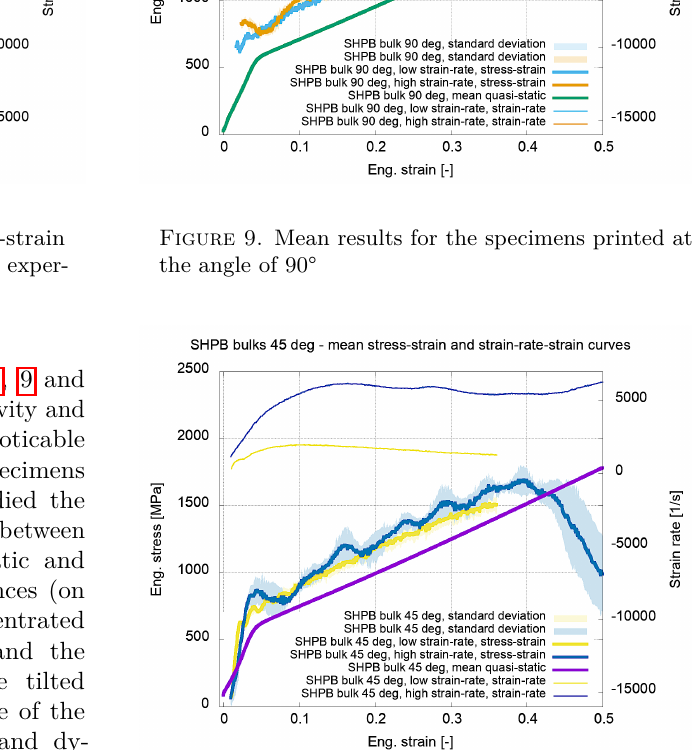
Figure 10. Mean results for the specimens printed at the angle of